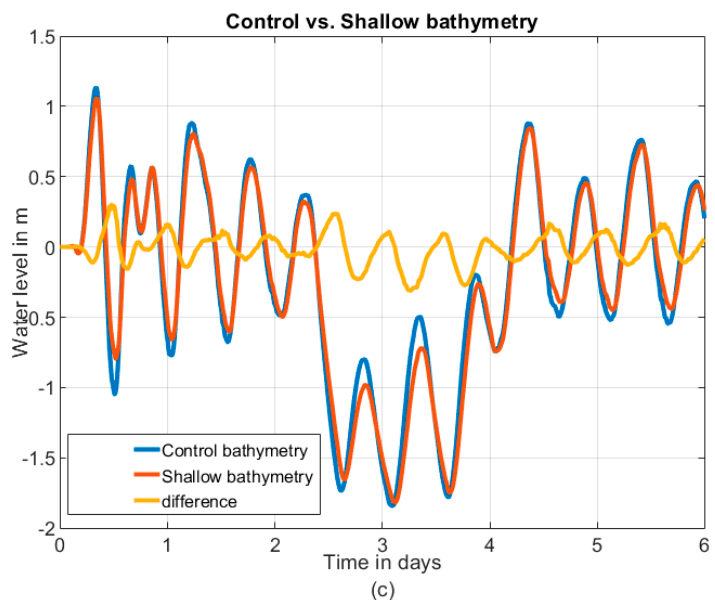
Figure 9. Time series of water level (storm tide) and surge during a blowout event using a random tide. Panels show: ( a ) simulation results for a tide / west wind simulation with control bathymetry; ( b ) results with shallow bathymetry; and ( c ) time series of total water levels for control bathymetry and shallow bathymetry, and the difference between the two.